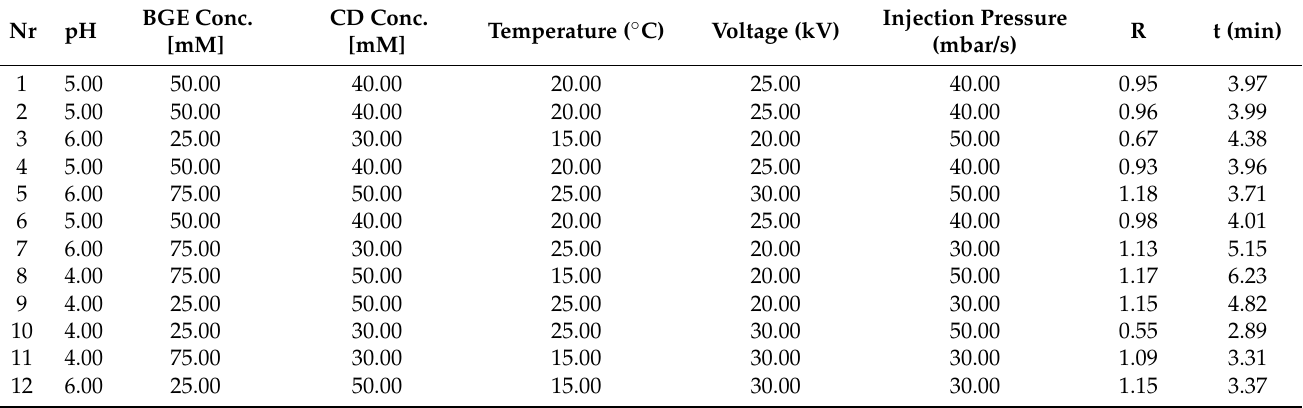
Table 1. Experimental plan and results obtained in the 2 6 − 3 fractional factorial screening